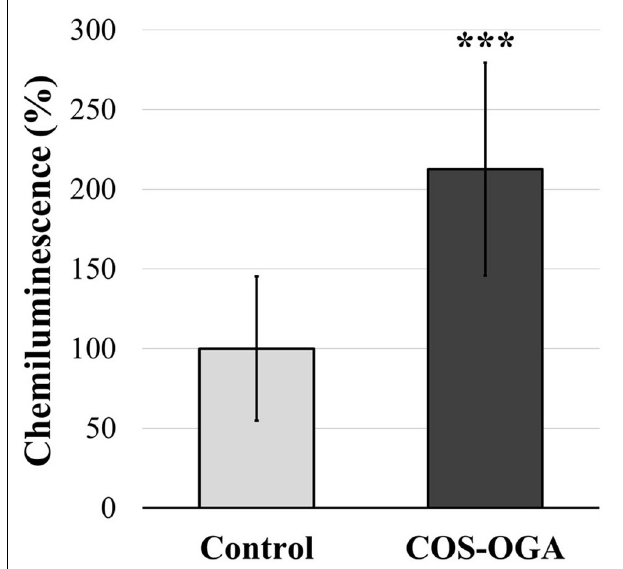
FIGURE 7 | Normalized class III peroxidase activity of tomato leaves after three sprayings with chitooligosaccharides–oligogalacturonides (COS-OGA; 62.5 mg/l). Tomato leaves were harvested 24 h after the third treatment. The average peroxidase activity of the elicited plants is expressed as a percentage of the control ± standard deviation ( n = 12). ***indicates a statistically significant difference to control according to Student’s t test ( p < 0.001, R ). the top leaves (Tsuyama et al., 2003; Dinç et al., 2012; Mänd et al., 2013). The parameters measured, especially NPQ, qL, and (cid:56) PSII, do not reflect the photosynthetic capacities of all the chloroplasts present in the leaves (Peguero-Pina et al., 2009), although pigment contents were measured on whole leaves.